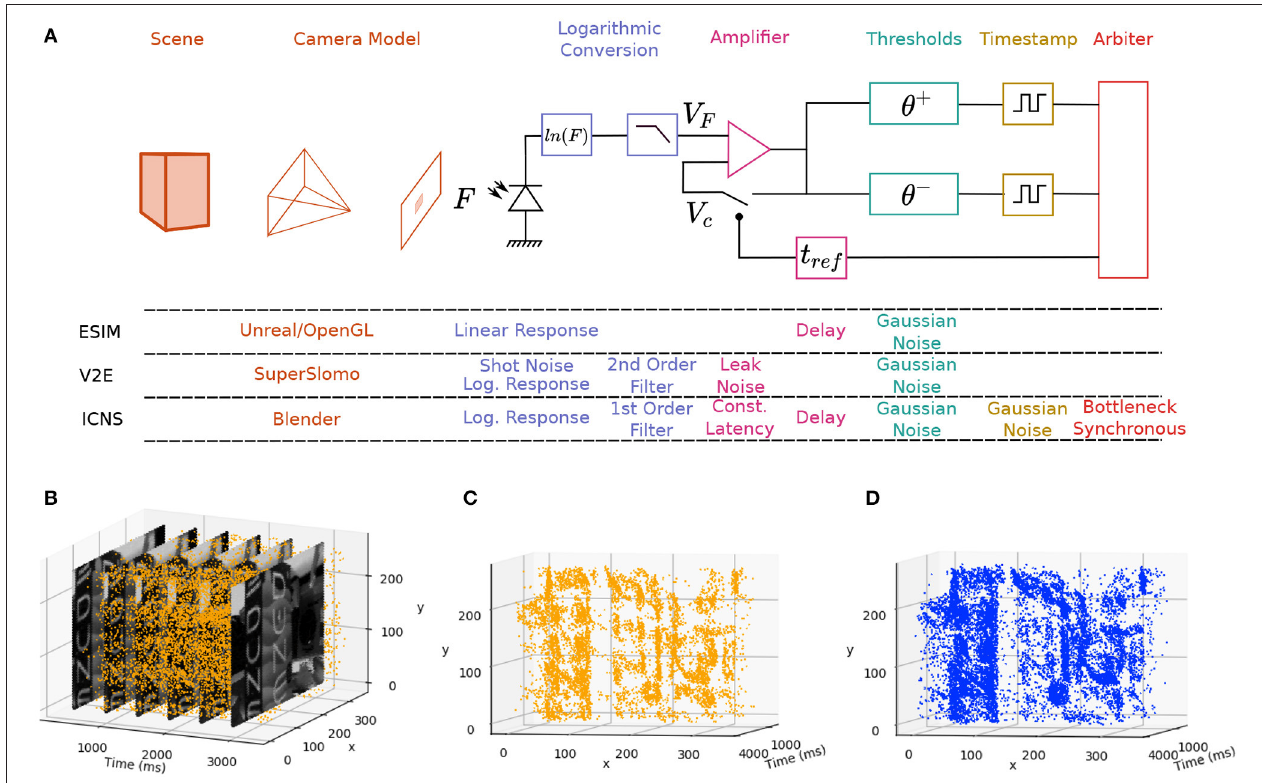
FIGURE 1 | (A) Main blocks of an imaging system based on a DVS camera simulated by ESIM, V2E, and our model (ICNS). The Scene and Camera Model are often part of the same rendering tool, but slow motion interpolation neural networks such as SuperSlomo can help provide better time precision. The Logarithmic Conversion block encapsulates the conversion of the light into an electrical signal before the Amplifier and the Thresholds. In the ICNS model, the noise is also injected before the Timestamp block and the noise distribution is a function of the light level. (B) Events and frames from the DAVIS and comparison between the original events (C) and the simulated events (D) using the ICNS